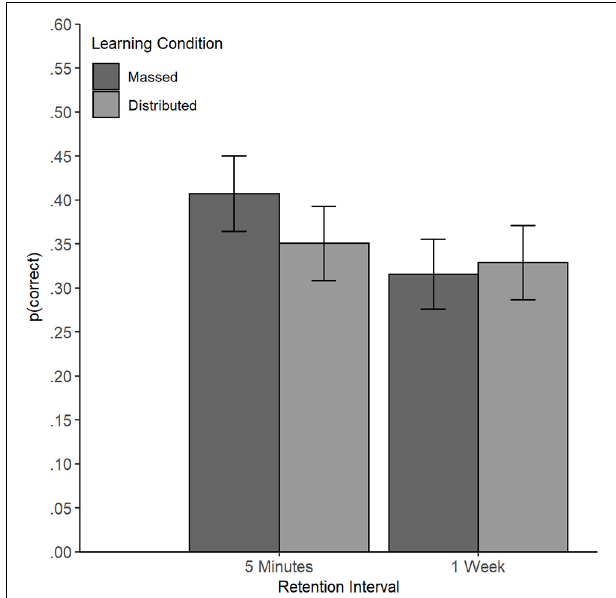
FIGURE 5 | Interaction Between Learning Condition and Retention Interval in Experiment 2. Learning outcomes (text comprehension) by learning condition at the short and long retention interval in Experiment 2 [estimates based on Model 1, back-transformed probability (p) of a correct answer]. Error bars represent standard errors ( ± 1